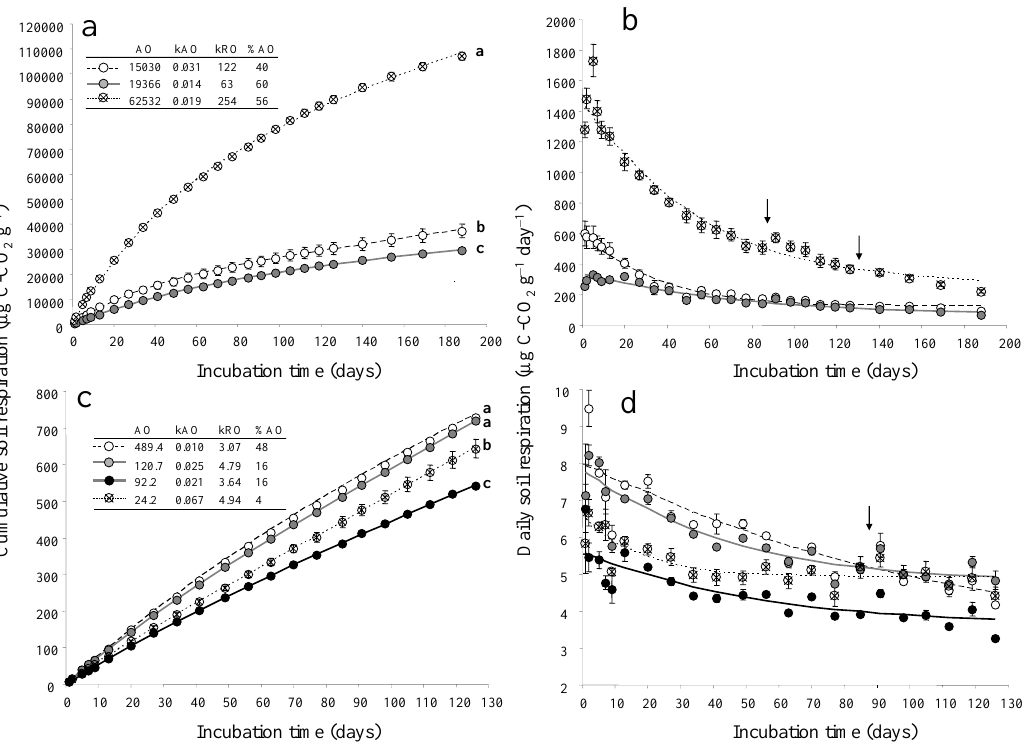
Fig. 1. Cumulative and daily soil respiration of incubated forest floors ( a , b ) and surface mineral soils (horizon A or A + AE) ( c , d ). Means ± standard error ( n obs = 4 aliquots and jars for each composite sample). Open symbols, plot 1; grey symbols, plot 2; black symbols, plot 3; hatched symbols, plot 4. Solid lines, adjustments (two-pool model; Eq. (1); r 2 = 0 . 926 − 1 . 000; P< 0.0001). Inset tables in (a) and (c) , parameters of the two-pool model (AO = pool size of the readily available organic pool; k AO = first-order rate of mineralization of the readily available organic pool; k RO = rate of mineralization of the recalcitrant organic pool) and readily available organic pool mineralized in 126 or 188 days in % of total mineralized organic C (%AO). Different lowercase letters in (a) and (c) denote significant differences between composite samples in cumulative soil respiration after 126–188 days. Arrows: adjustment of soil moisture after 85 and 126 days, flush effect due to the adjustment of soil moisture after 85